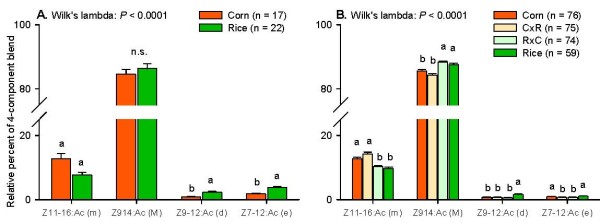
Between-strain comparisons of the pheromone composition between corn and rice strain females, including only the four compounds that have been shown to affect conspecific male attraction. The total percent of the four compounds add to 100%. Different letters above the bars of one component indicate significant differences. N.s: not significant.